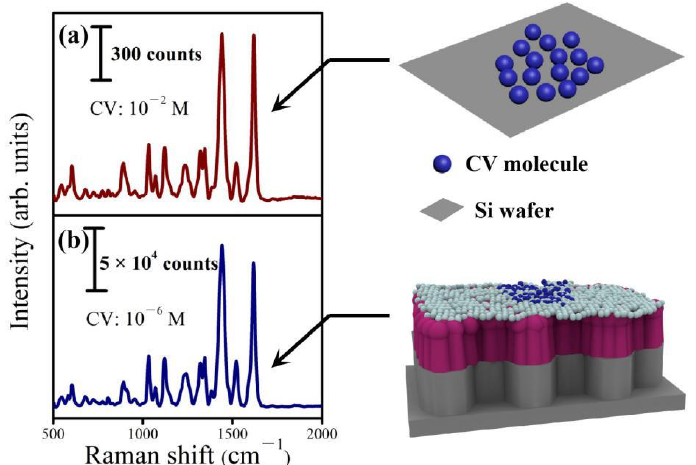
Figure 10. ( a ) SERS spectra of 10 −2 M CV solution on the Si wafer; ( b ) SERS spectra of 10 −6 M CV solution on the Ag NPs 30 -Ag 20 -AAO SERS substrate.